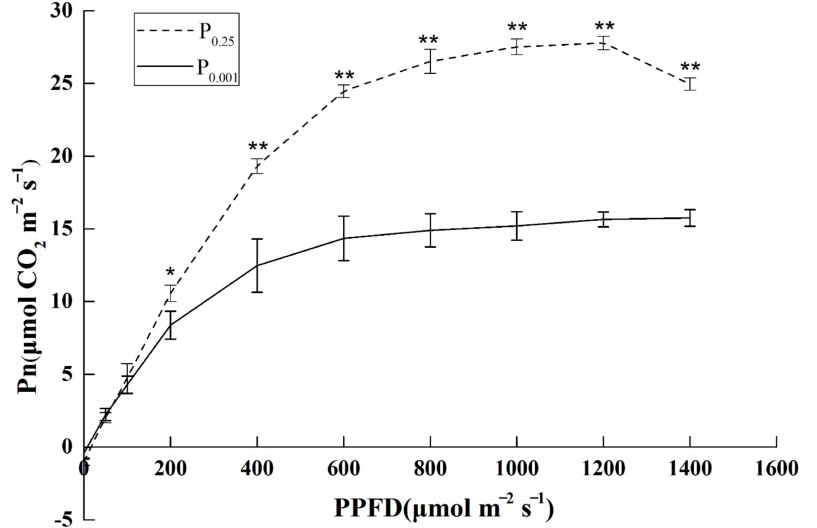
Figure 1. The seedling photosynthetic light–response curves under the different Pi treatments. Pn: net photosynthesis rate; PPFD: photosynthetic photon flux density. The error bars indicate the standard deviation (SD; n = 4). The asterisks indicate the significant differences according to Tukey’s test using a one-way ANOVA (* p < 0.05; ** p < 0.01).